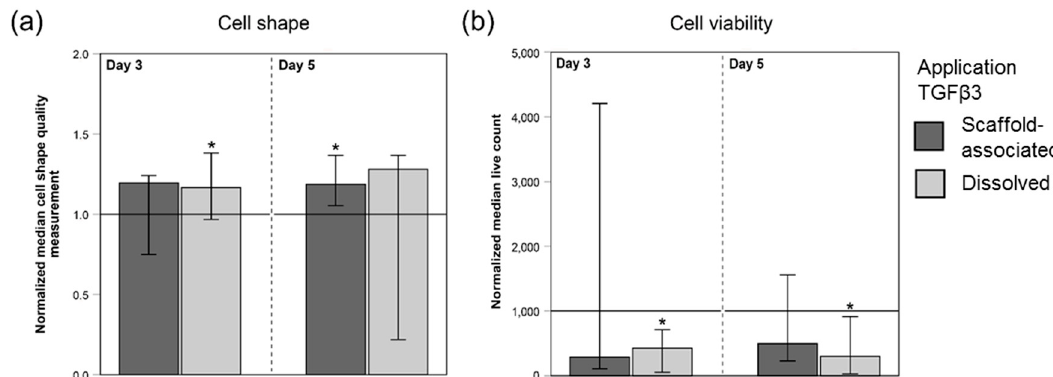
Figure 3. Quantitative image analysis results of LIVE / DEAD ® -stained, MSC-seeded tendon sca ff olds. Values of the cell shape measurements ( a ) and of the numbers of viable cells ( b ) were normalized to the corresponding internal controls (w / o TGF β 3; indicated by the horizontal line intersecting the x -axis at 1.0). Higher values of the cell shape measurement in ( a ) correspond to more elongated cells. MSC-seeded tendon sca ff olds were either directly loaded with TGF β 3 (sca ff old-associated) or TGF β 3 was supplemented via the cell culture medium (dissolved). The total number of sca ff olds within each group was 42 ( n = 42). Bars represent the normalized median values and error bars the 95% confidence interval; one extreme outlier value was removed (sca ff old-bound TGF β 3 group in ( b ), day 3) before plotting the graph; * illustrates significant di ff erences compared to the respective untreated control group (w / o TGF β 3) ( p < 0.05).